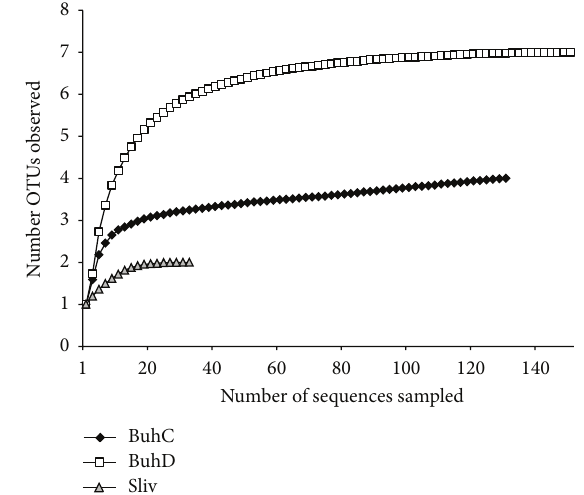
Figure 2: Rarefaction curves indicating archaeal 16S rRNA richness within BuhC (SSL 97%), BuhD (SSL 94%), and Sliv (SSL 91%) clone